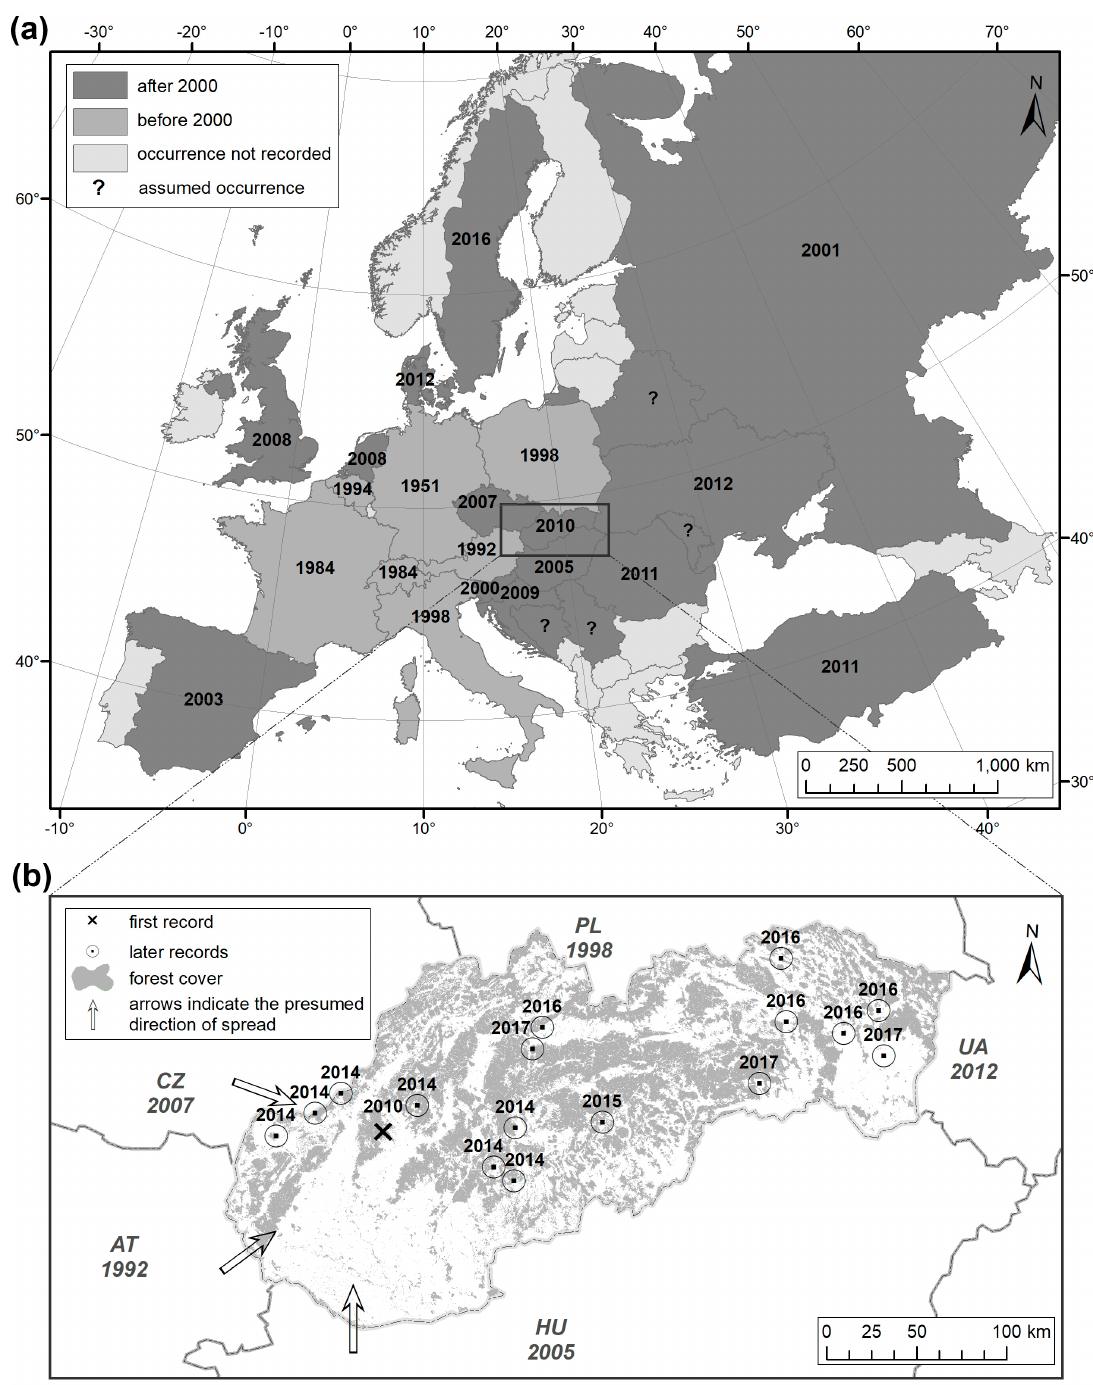
Figure 1. The occurrence and spread of Xylosandrus germanus across ( a ) Europe and ( b ) within Slovakia. Records are indicated by years (AT—Austria, CZ—Czech Republic, PL—Poland, UA—Ukraine, HU—Hungary).